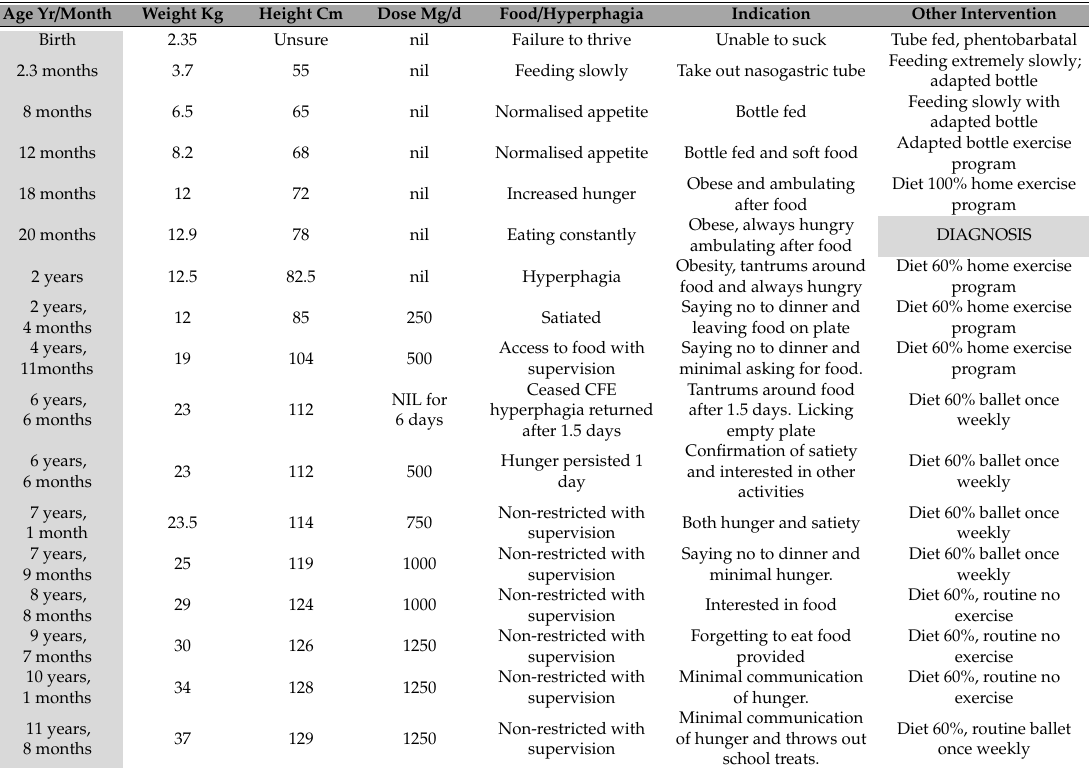
Table 1. Age and anthropometric measurements in single-case with Prader-Willi syndrome (PWS) ingesting Caralluma fimbriata extract (CFE) . Anthropometric measurements behavioural indications of hyperphagia and additional intervention / exercise, in a single case of a female with PWS ingesting CFE over 12 years. The case begins as a newborn and ceases at 14 years and 4 months of age. Weight in Kg—kilograms, height in cm—centimetres, nil—represents no intervention, dose in mg—milligrams, per